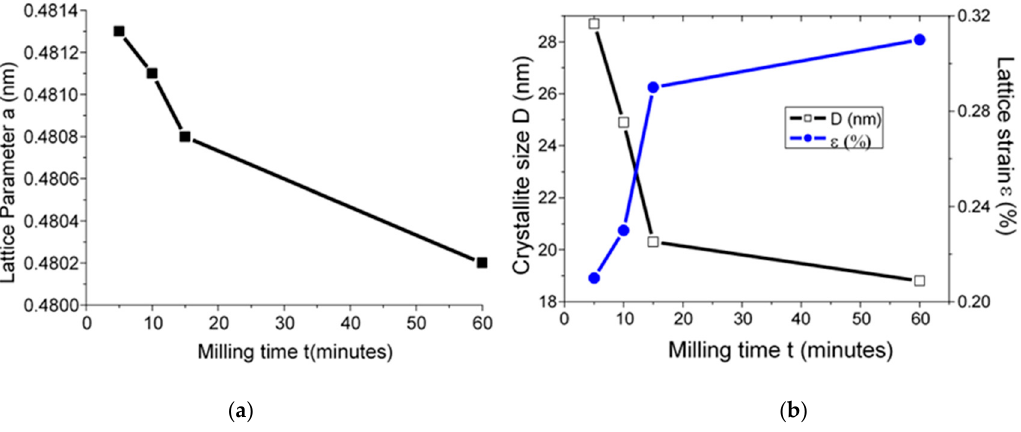
Figure 8. Evolution at 900 °C of CaO versus milling time t (minutes) of: ( a ) lattice parameter (nm), ( b ) crystallite size and lattice strain.